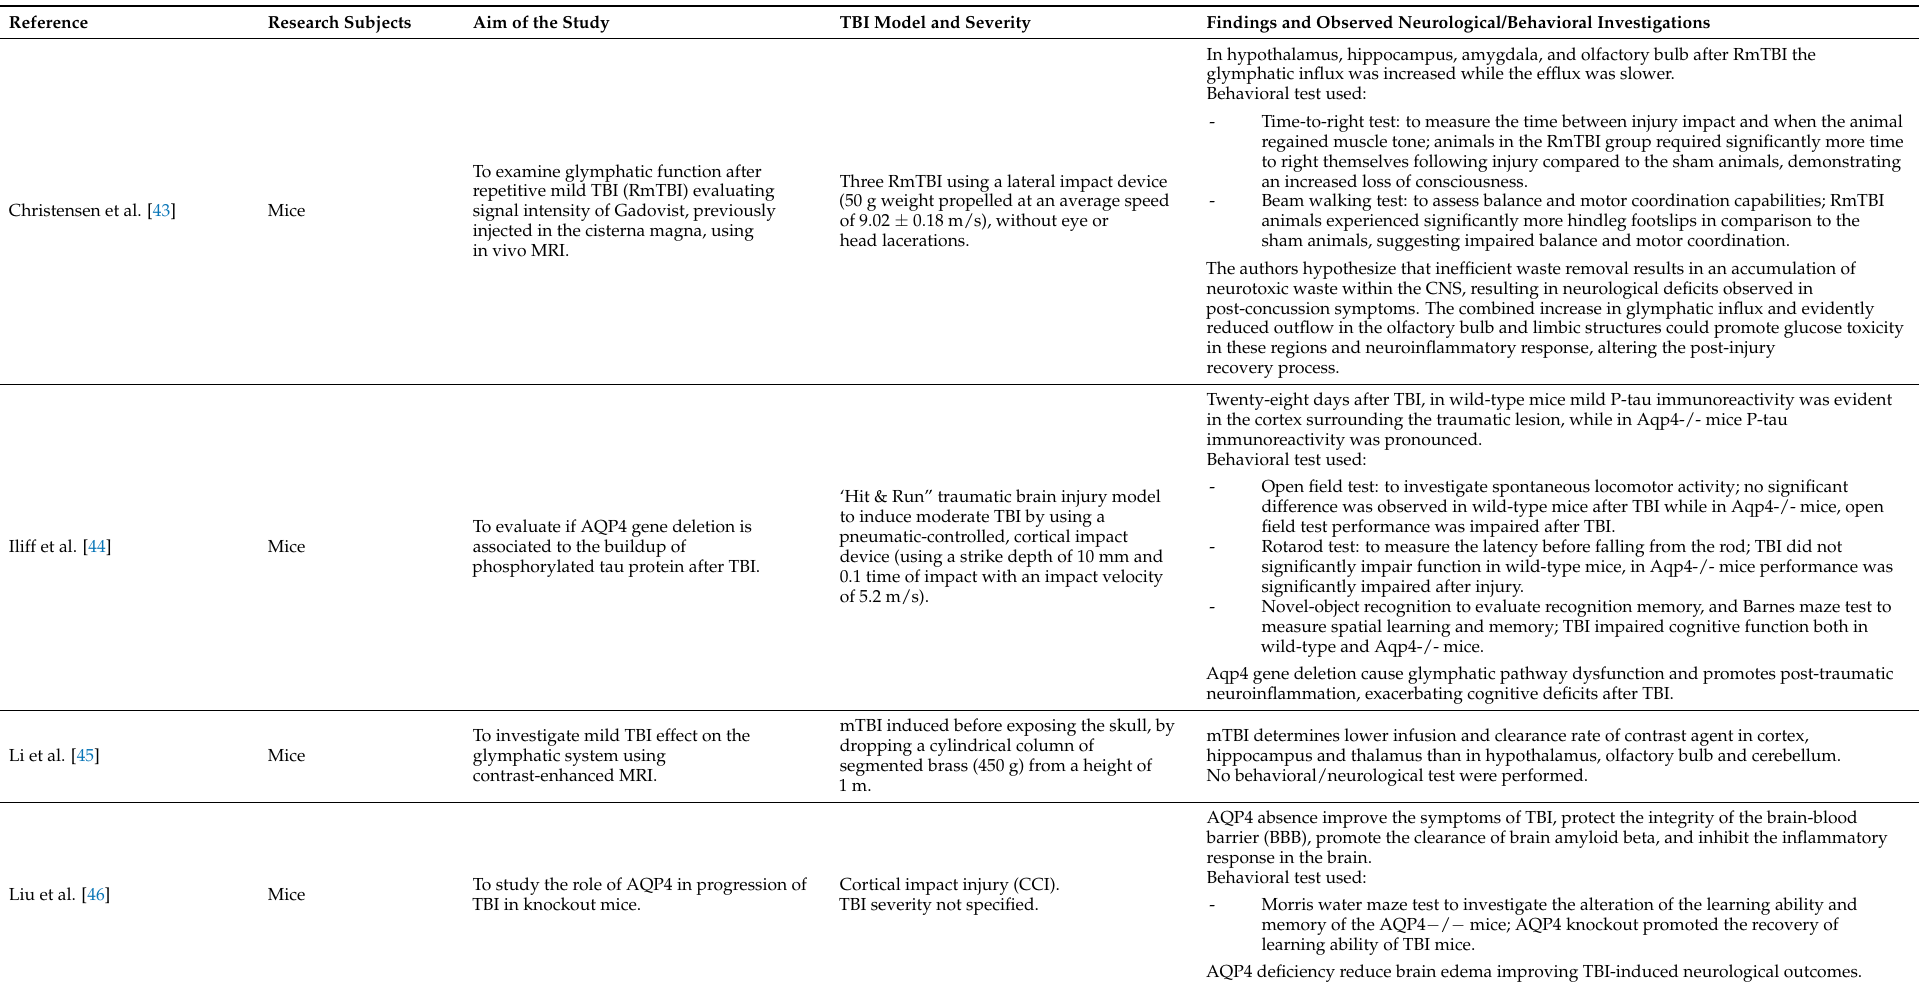
Table 2. Results of the systematic